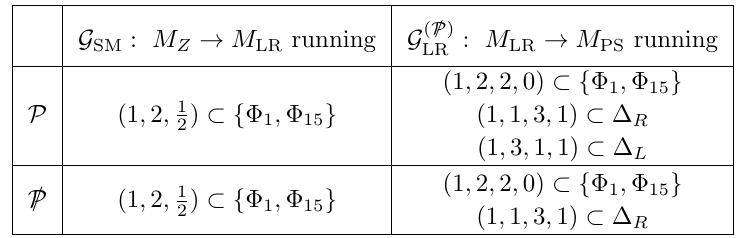
Table 2 . Surviving intermediated-scale scalars and their Pati-Salam origin, according to the ESH. Transformation properties under the G SM and G ( = P )